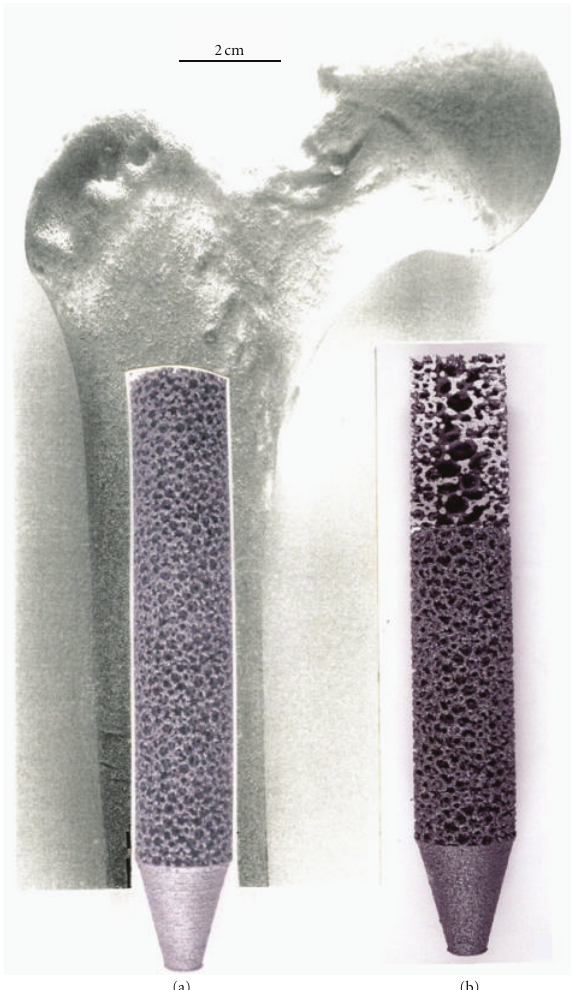
Figure 15: Upper femur with simulated intramedullary rod insert fabricated from Ti-6Al-4V by EBM in (a). (b) shows a through-section cutaway view illustrating inner, more porous foam core surrounded by more dense foam structure for sti ff ness